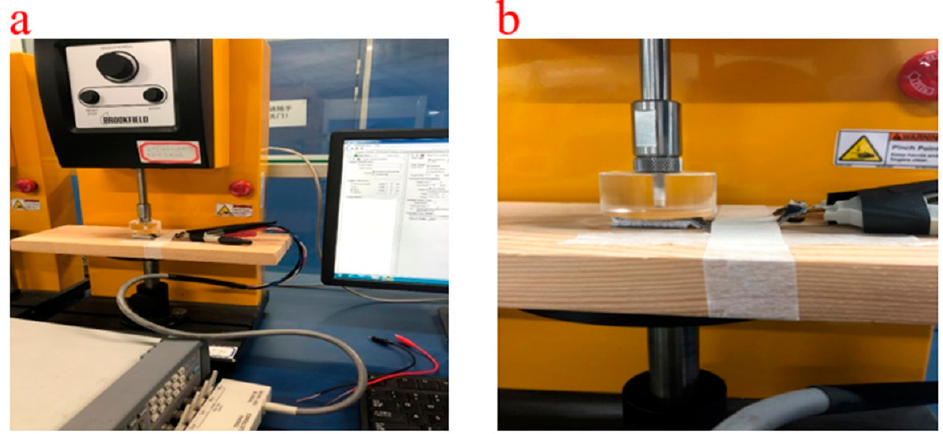
Figure A2. ( a ) Photo of the durable test machine, ( b ) photo of the sensor before stretch, ( c ) photo of the sensor at 40% elongation. Figure A3a is the photo of the sensor before the compression test, Figure A3b is the photo of the sensor under the compression test.